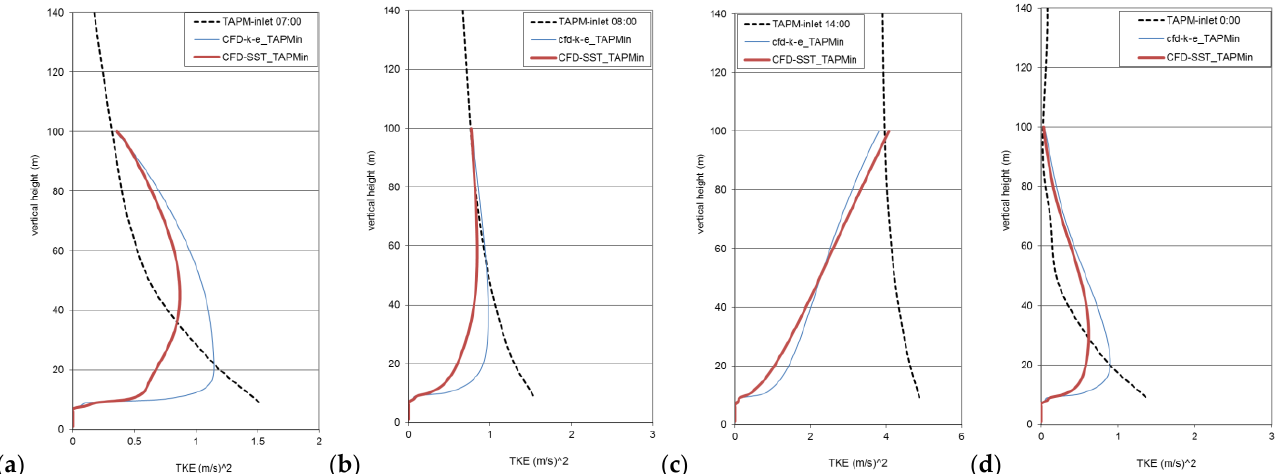
Figure 6. Vertical profiles of wind turbulence kinetic energy over position 2 (Figure 1), corresponding to four stability conditions ( a ) D, ( b ) C, ( c ) B, ( d ) E (Table 1). Comparison of CFD results using two different turbulence models (k- ε and SST). M esoscale results (“TAPM - inlet”) are also shown.